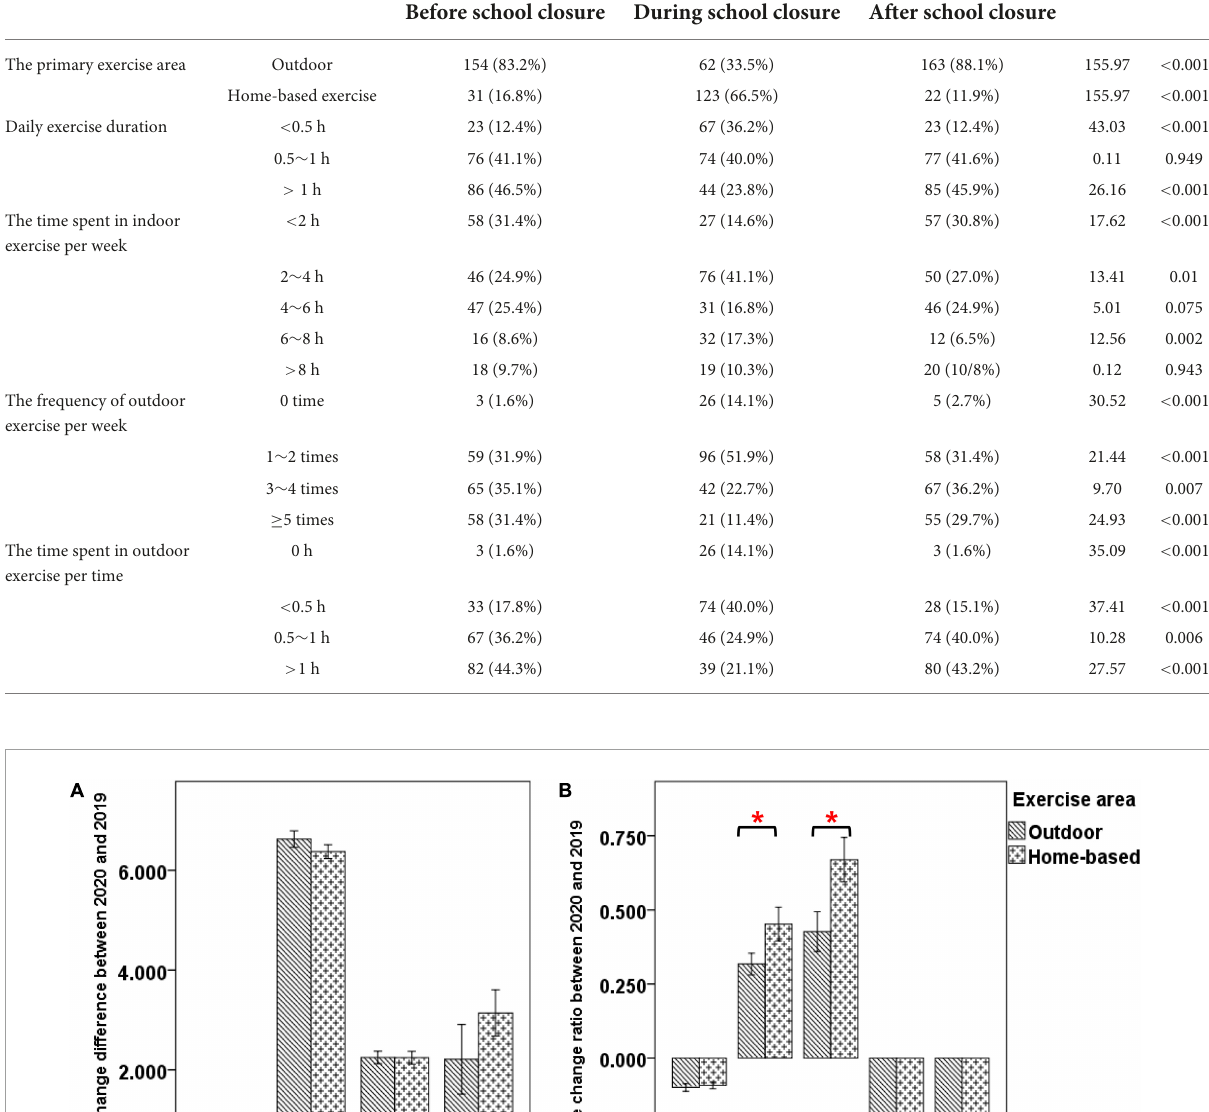
TABLE 4 The exercise profile of 185 children before, during, and after COVID-19 school closure.